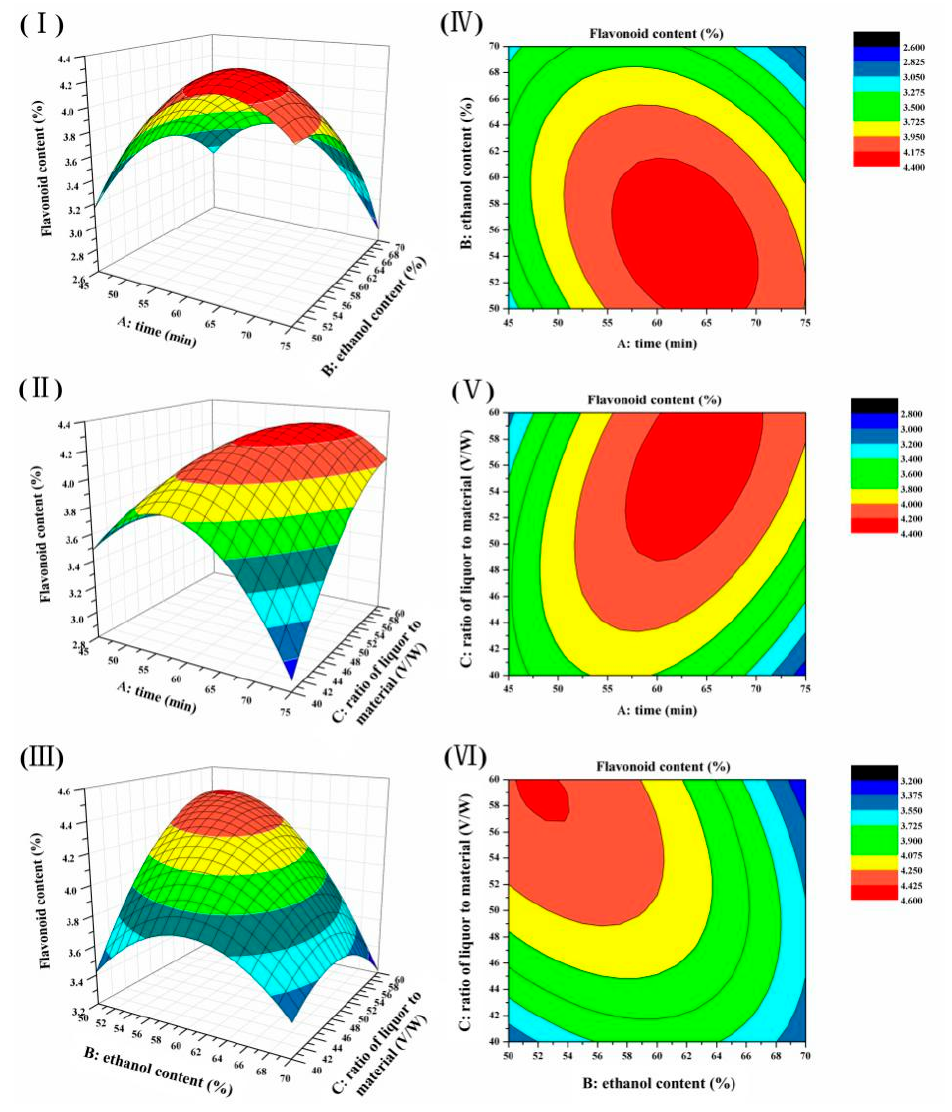
Figure 2. Response surface plots. ( I – III ) were showing the effects of extraction time (A), ethanol content (B), and (C) ratio of liquor to material on the content of total flavonoids, respectively. ( IV – VI ) were their contour plots, respectively.